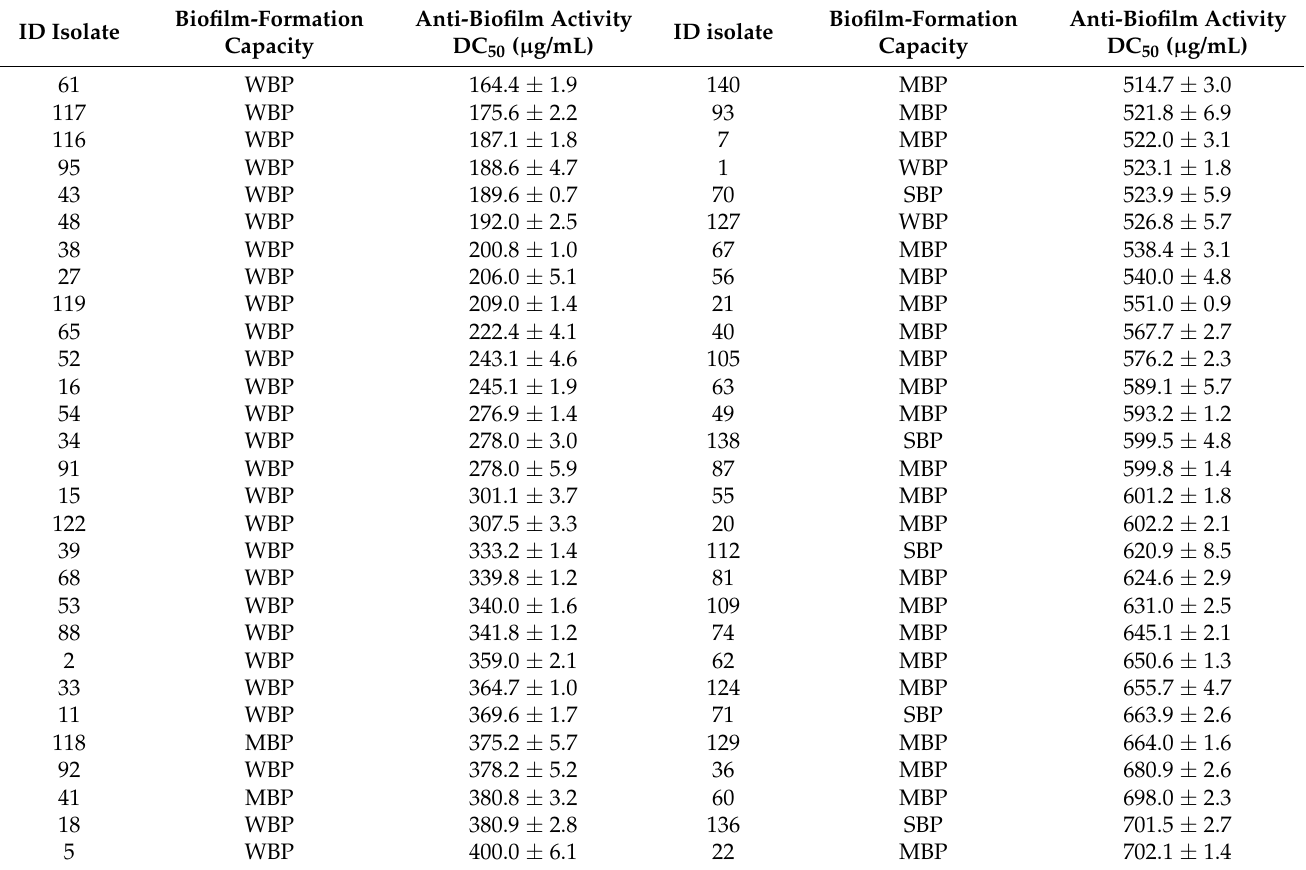
Table 5. Fosfomycin efficacy (DC 50 ) on biofilm-associated MDR UPEC clinical